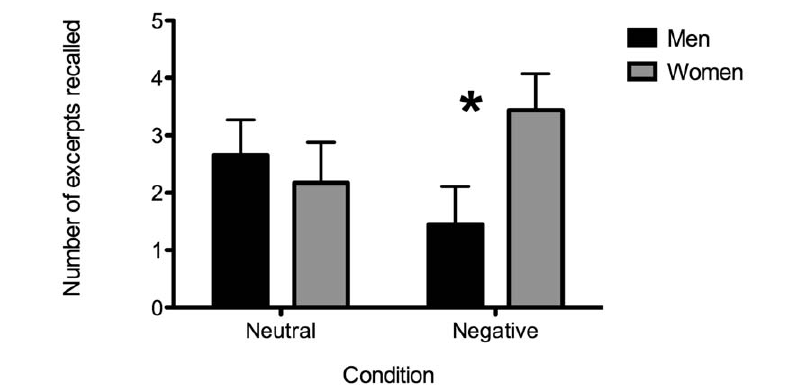
Figure 3. Mean delayed memory performance for the news excerpts as a function of Condition (neutral, negative) and Sex (men, women). Adjusted means as a function of ‘emotionality’ and ‘concerned’ are presented. The error bars represent the standard error of the mean. The asterisk (*) means p , 0.05.